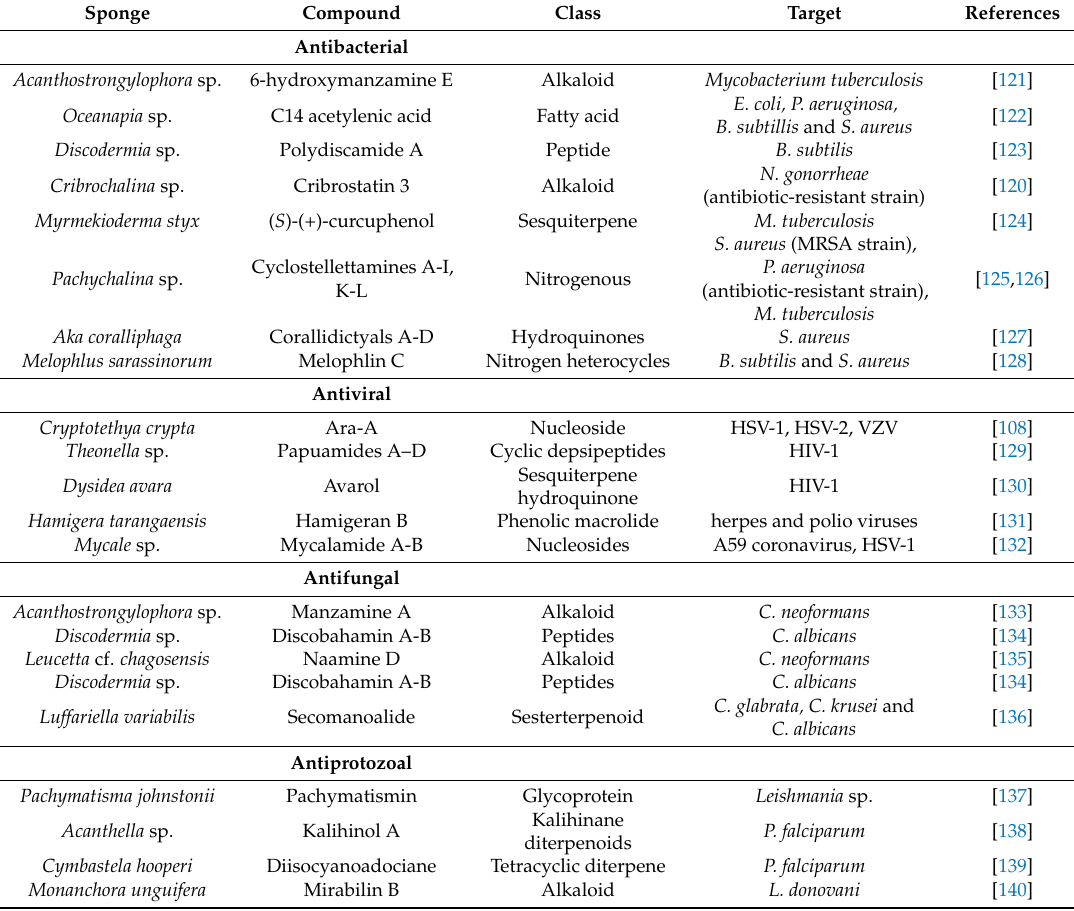
Table 1. Biologically active compounds with antibacterial, antiviral, antifungal, and antiprotozoal activity from marine sponges